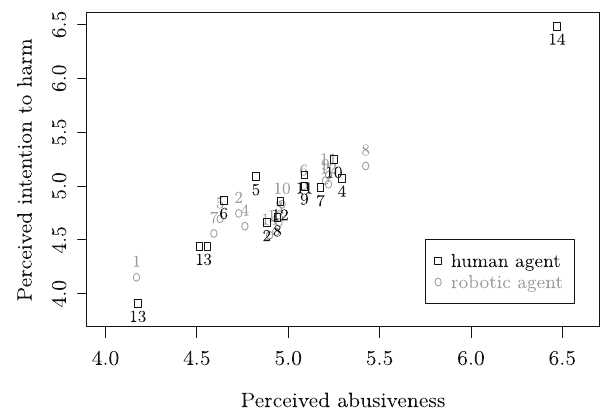
Figure 3: Plot of the 14 videos on perceived intention to hurt and abuse, separated for human and robotic agents. The numbers refer to the video